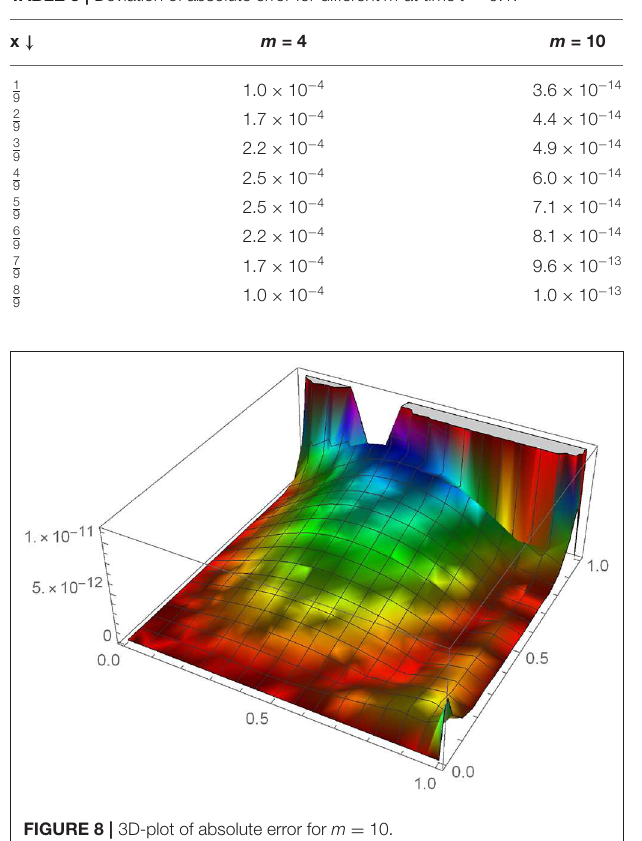
TABLE 4 | Deviation of absolute error at time t = 0.1.